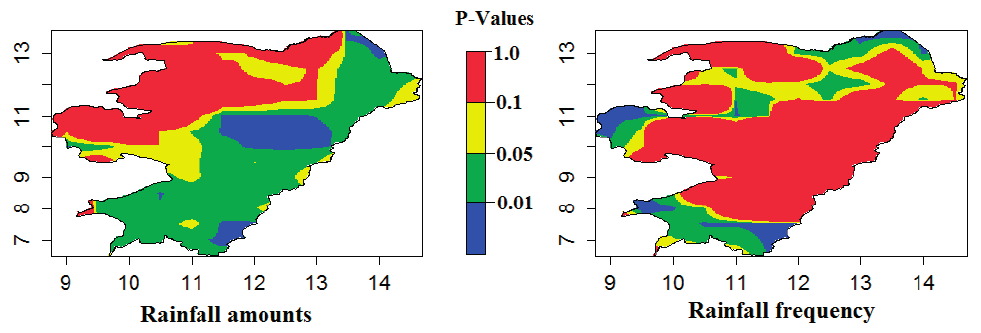
Figure 6. P -values of a Student’s t -test between standard normal deviates of the prediction and standard normal deviates of the means of the long-term monthly data used for the prediction. The months used for this test at each grid scale were